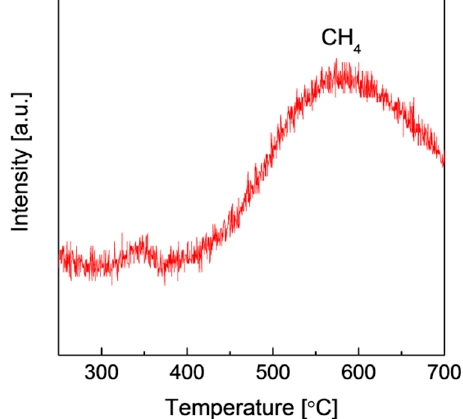
Figure 10. Mass spectra of SS ‐ 40 Ru/graphene nanocomposites under a H 2 atmosphere and different temperatures.